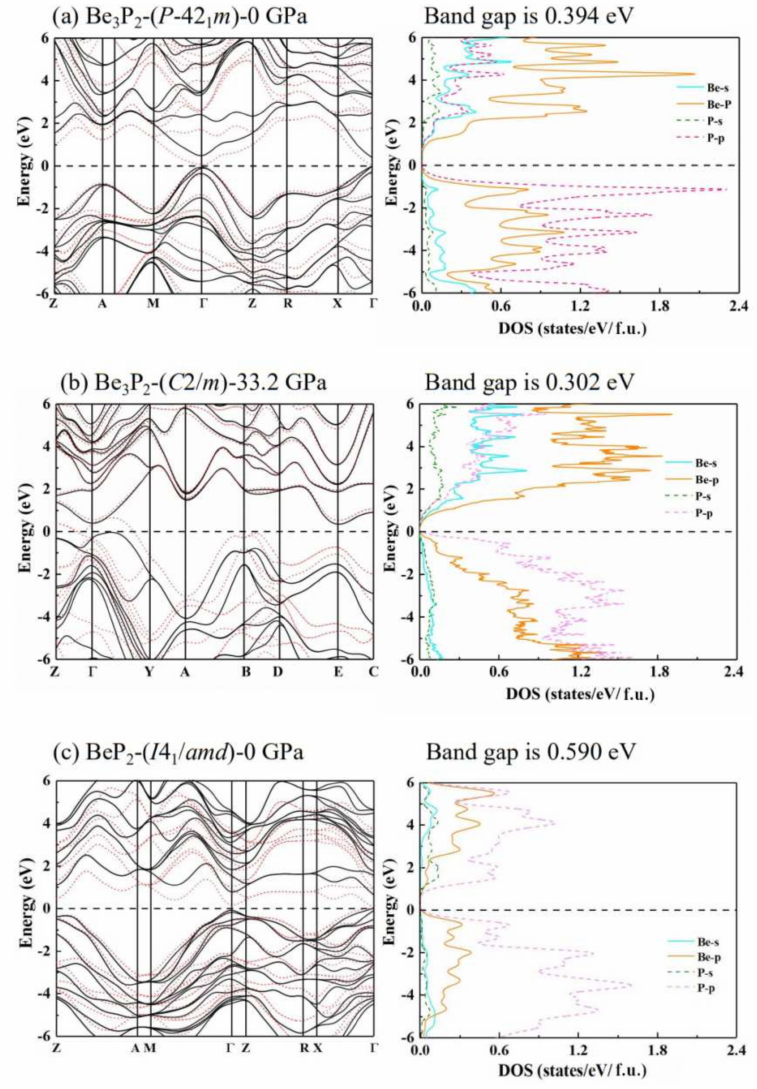
Figure 5. (color online). Electronic band structures and PDOS for ( a ) Be 3 P 2 − P − 42 1 m at 0 GPa, ( b ) Be 3 P 2 − C 2 /m at 33.2 GPa, and ( c ) BeP 2 − I 4 1 /amd at 0 GPa. Note that zero energy is on the Fermi level. The dotted (red) and solid (black) lines represent results obtained using the PBE and HSE functional,